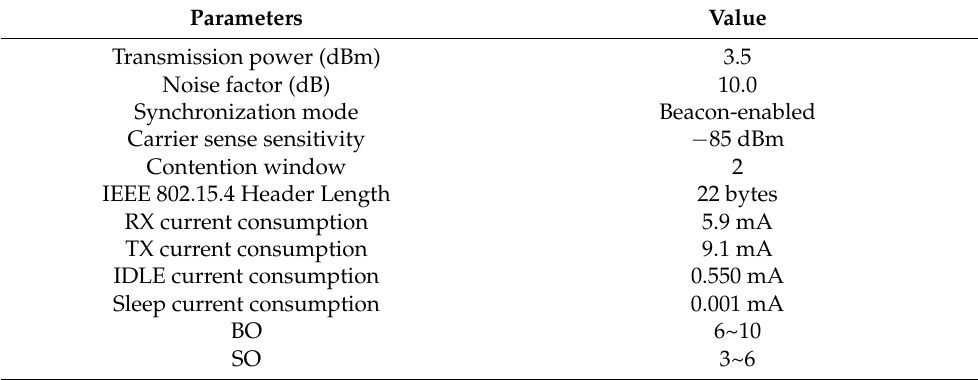
Table 2. Smart grid application.